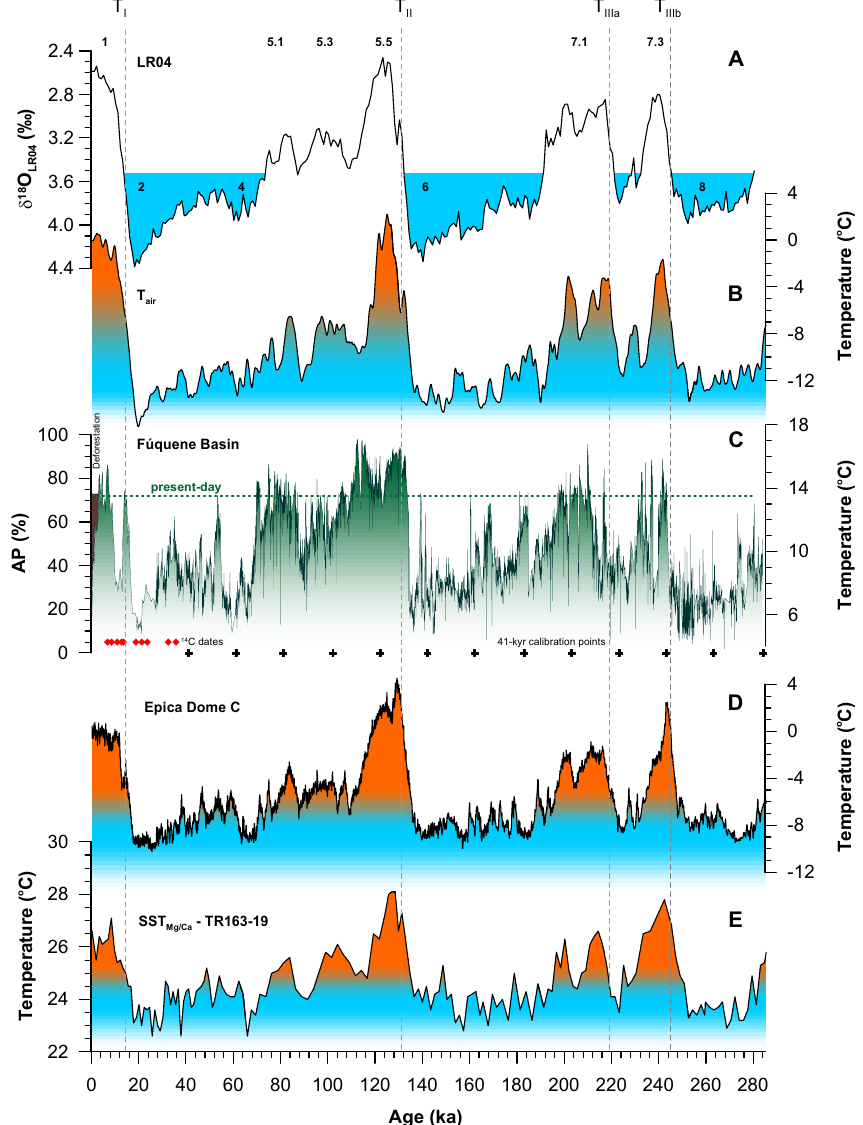
Fig. 6. Comparison between the mean annual temperature (MAT) changes at Lake F´uquene with other paleoclimate records. (A) LR04 benthic δ 18 O stack (Lisiecki and Raymo, 2005). (B) Modeled NH air temperatures (Bintanja et al., 2005). (C) AP%-based MAT at Lake F´uquene. (D) The deuterium-based temperature record of Epica Dome C (Jouzel et al., 2007; Parrenin et al., 2007). (E) Mg/Ca-derived sea surface temperature (SST) record of TR163-19 (Lea et al., 2000). The numbers in (A) indicate Marine Isotope Stages. Brown shaded area in (C) represents a deforestation